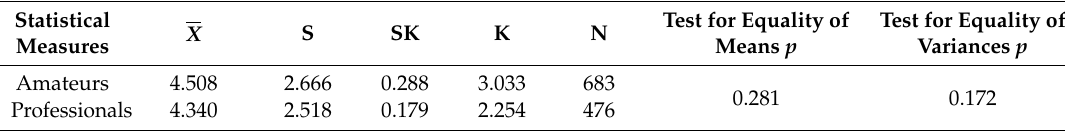
Figure 6. Difficult access to a sports and recreation facility, in the opinion of service recipients (professional athletes). Source: own work. Table 7. Statistical measures of di ffi cult access to a sports and recreation facility, in the opinion of service